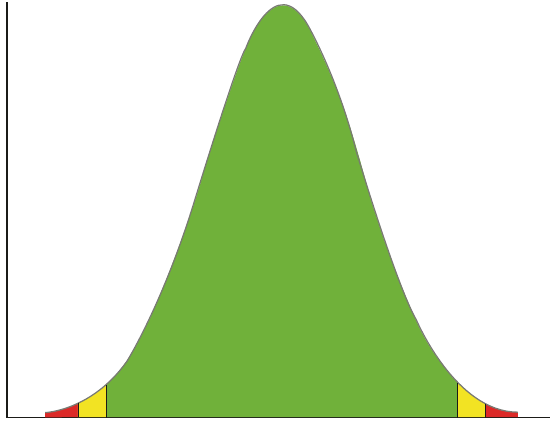
Figure 11: Anomaly likelihood